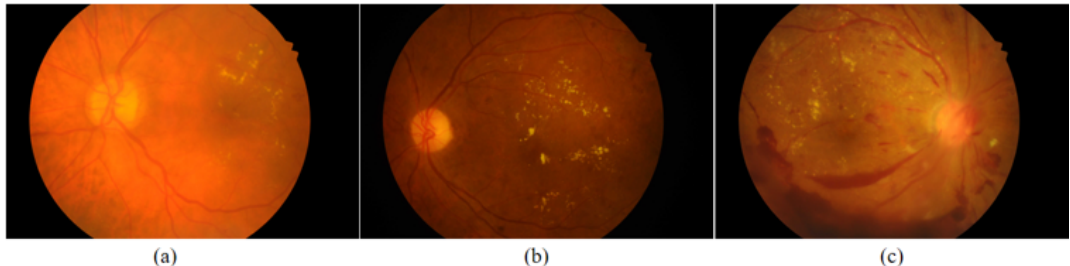
Figure 6. Examples of inconsistent image quality. These images show three types of inconsistency: ( a ) a too-bright image; ( b ) a too-dark image; and ( c ) an image with large hemorrhage and exudate areas.